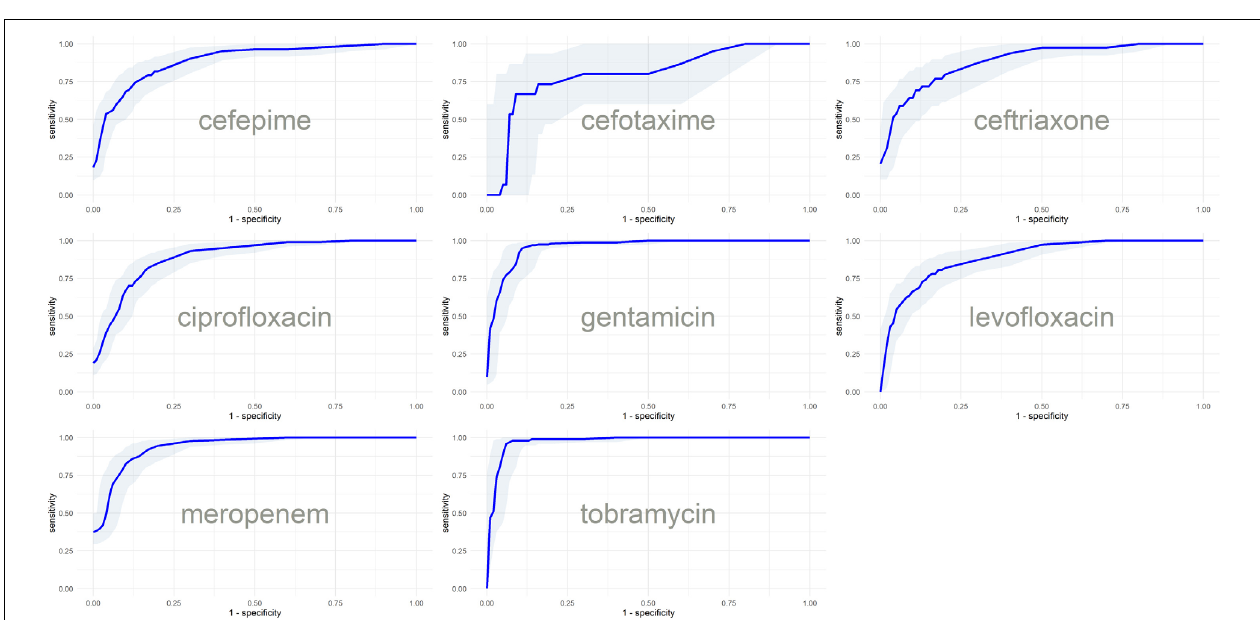
FIGURE 3 | Performance of XGBoost models based on 51 different splits of the data. Boxplots represent distribution of AUC for the corresponding testing subsets, with thick lines indicating the median performance.